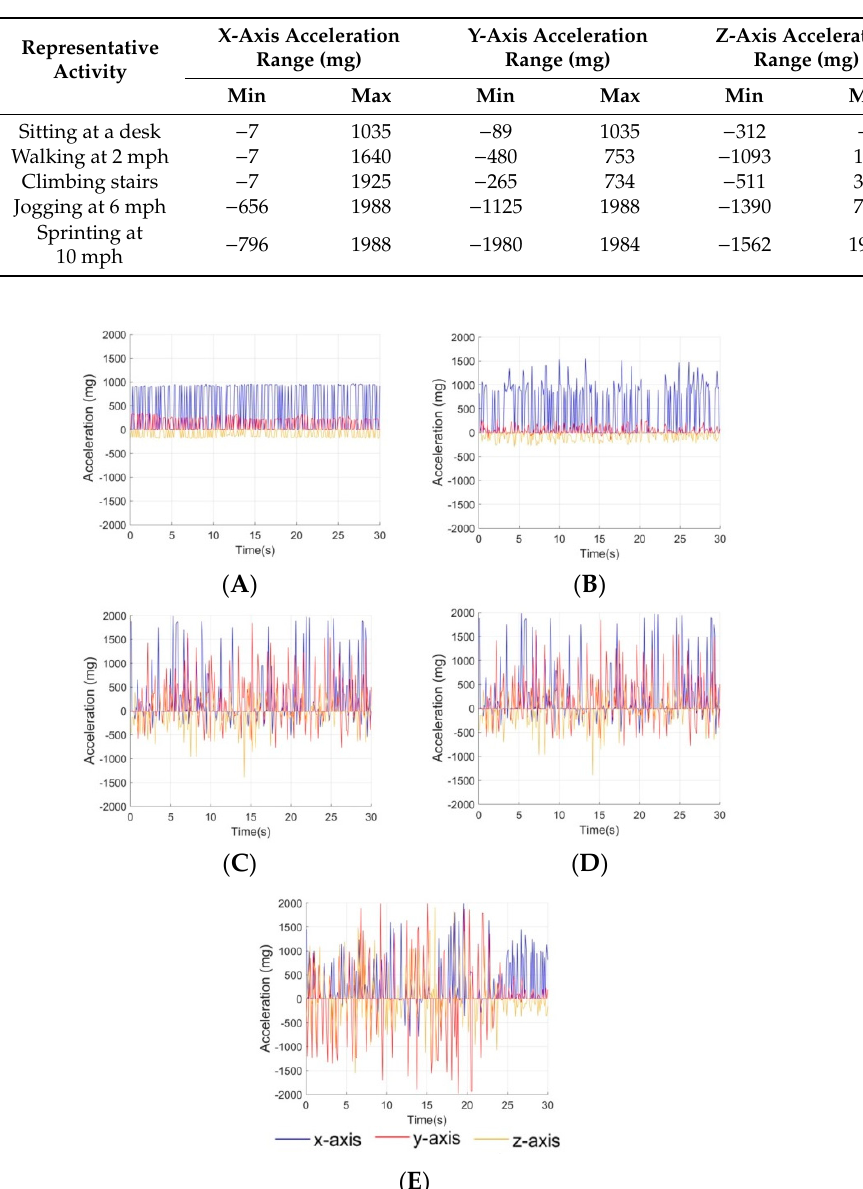
Table 1. An intensity scale was defined according to a set of representative activities. The acceleration ranges for each activity were used to differentiate between activity levels.